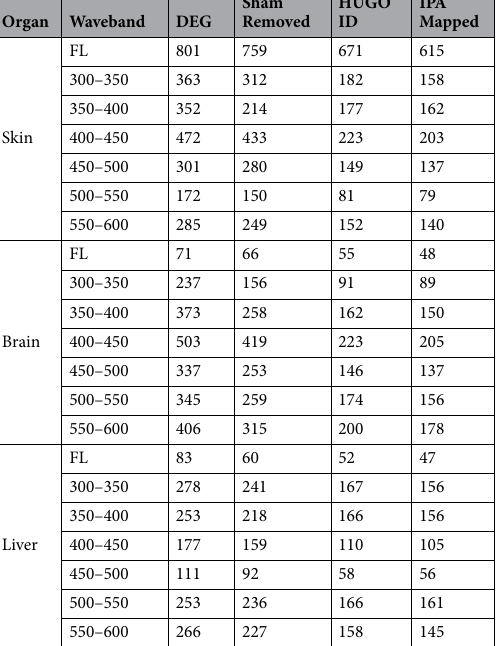
Table 1. The number of differentially regulated genes was determined following EdgeR (column 3), after sham removal (column 4), after assignment of human homolog genes (column 5) and after IPA analysis (column 6). Differentially expressed genes for FL exposed samples. Total modulated genes are the output file from EdgeR (column 2) that had a log 2 (fold change) ≥ |2.0| and a (p-adj < 0.05). All fish Ensembl IDs were converted to HUGO IDs (column 5) for IPA analysis. HUGO IDs were then imported and mapped by Qiagen’s IPA software for functional and pathway analysis (column